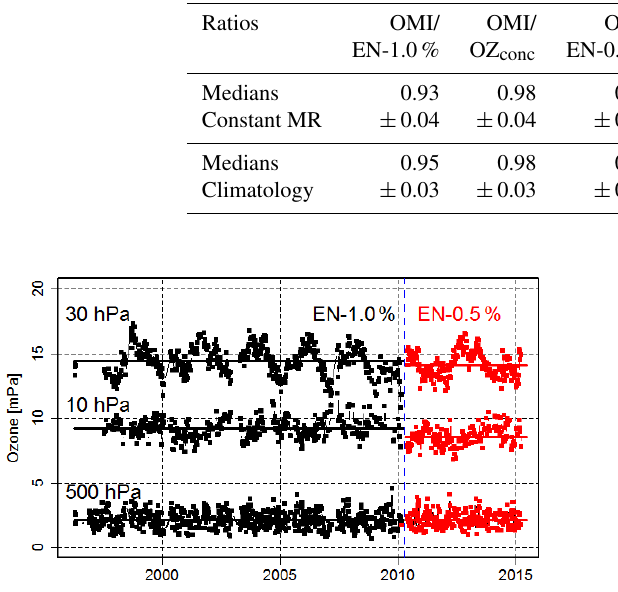
Figure 9. Ozone time series from the Nairobi station at three pres- sure levels: 500, 30, and 10hPa. The black symbols correspond to the data from 1996 to 2010 (EN-1.0% solution), and the red sym- bols from 2010 onwards (EN-0.5%). The horizontal segments are the mean values over the two periods. No corrections to the EN- 1.0% data have been made for this figure.